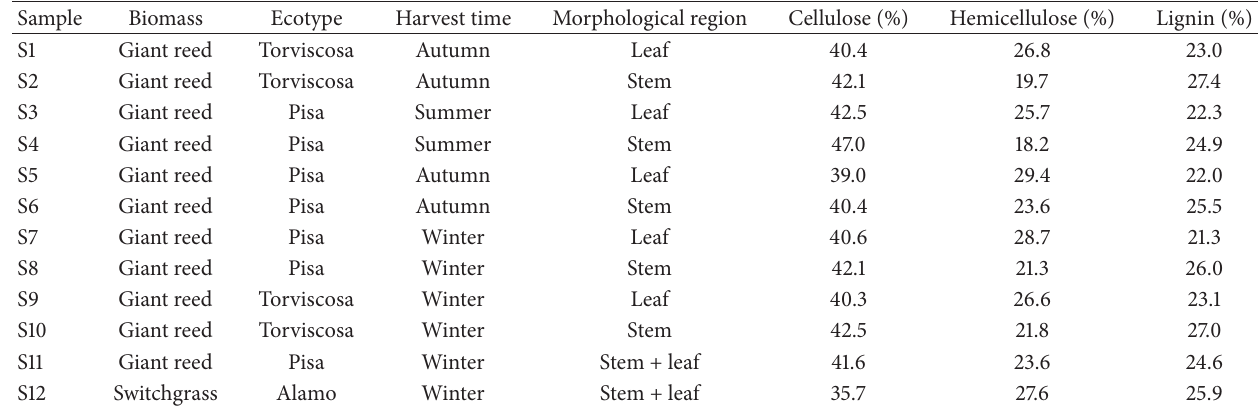
Table 2: Composition data obtained from the application of the ash-corrected predictive model for the quantification of cellulose, hemicellulose, and lignin in giant reed (S1–S11) and switchgrass (S12) biomass samples.